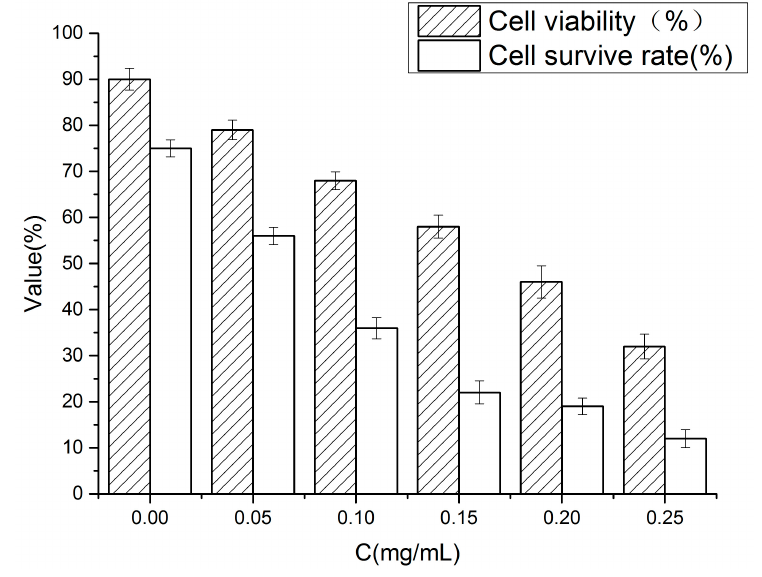
Figure 8. Cell survival rate and cell viability of Caco-2 cells treated with different concenteations of C3G nanoliposomes.